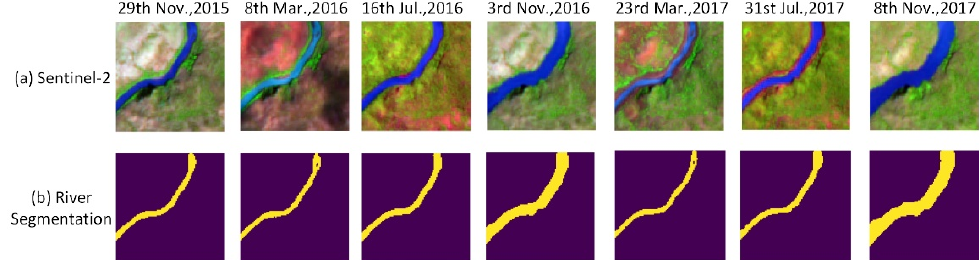
Figure 11. Long-term river monitoring Visualization based on river segmentation results. ( a ) Sentinel-2; ( b ) River Segmen- tation Result. Each column represents the river monitoring result among different time.